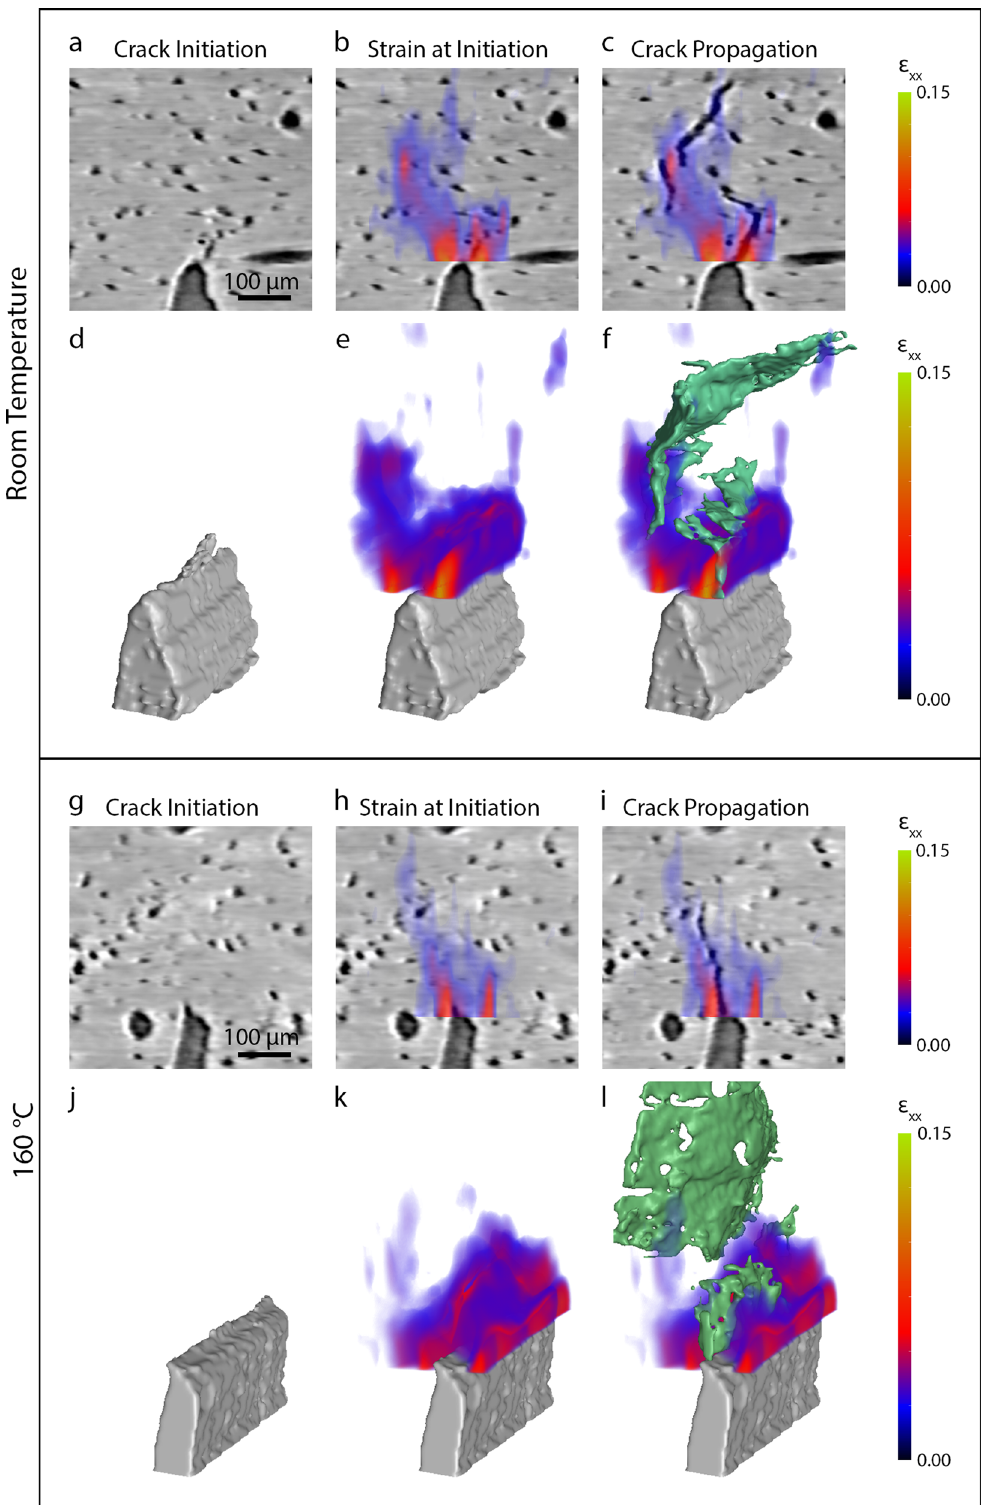
Fig. 5 The internal strain state, revealed by DVC, informs the trajectory of crack propagation. This is visualized by overlaying the strain ( ϵ xx ) on images of the notch and crack. Left to right, all images show an image of crack initiation, the image of crack initiation with the corresponding strain state overlaid, and the strain state at crack initiation overlaid on the image of the next step of crack propagation. In the 3D images the notch is colored in gray and the crack is colored in green. a – c Examples of 2D DVC results for a room temperature sample. d – f Corresponding examples of 3D DVC results for a room temperature sample. g – i Examples of 2D DVC results for a 160 °C sample. j – l Corresponding examples of 3D DVC results for a 160 °C